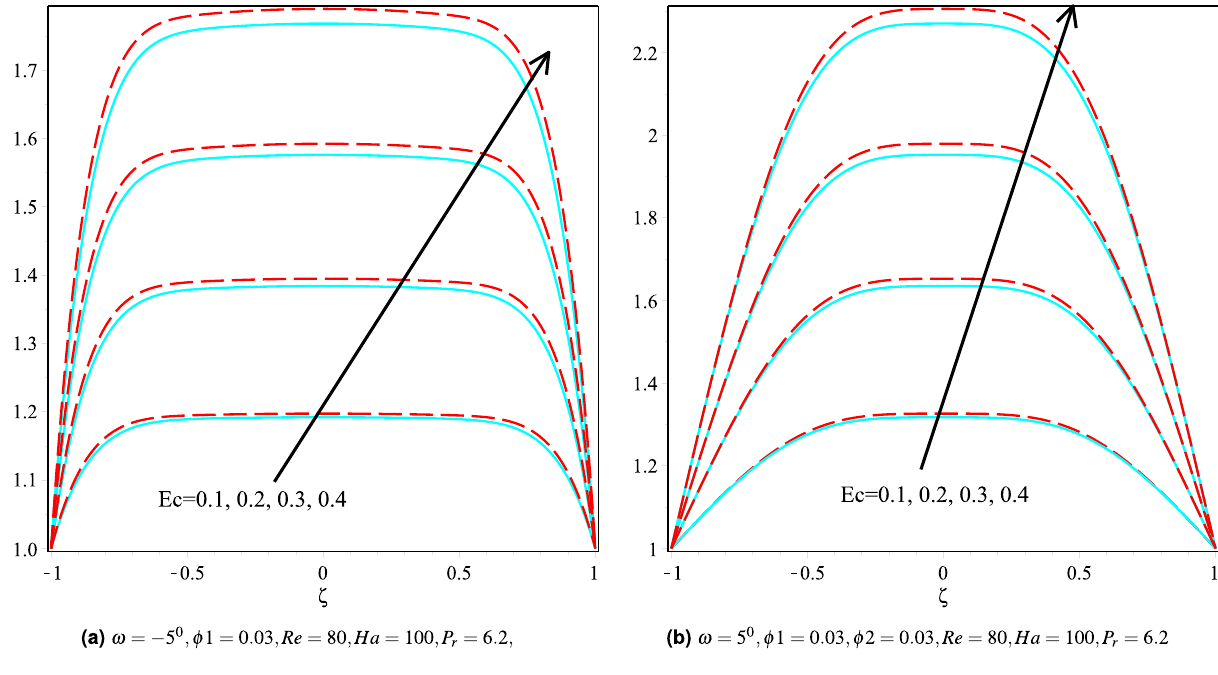
Figure 11. The heat boundary layers distribution in converging and diverging channel with various Eckert number for Cu/H 2 O and Cu-Al 2 O 3 /H 2 O, respectively.